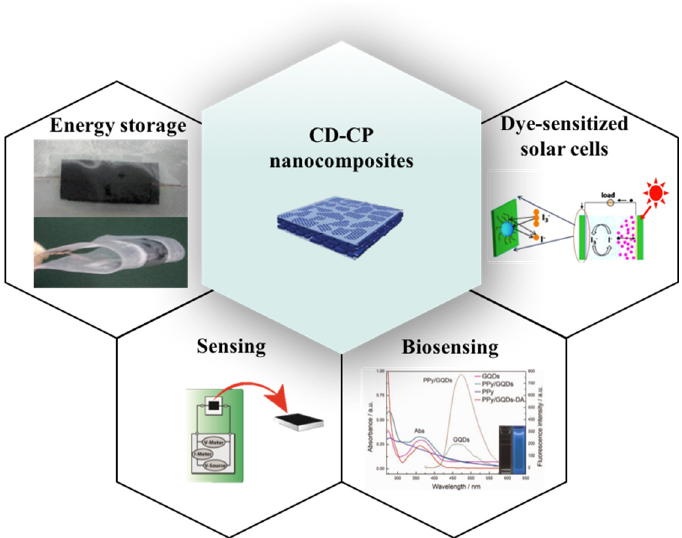
Figure 8. Applications where CD–CP composites have been applied. Adapted with permission from references [37,112,114,116], Copyright Elsevier (2015) and American Chemical Society (2013, 2016) and The Royal Society of Chemistry